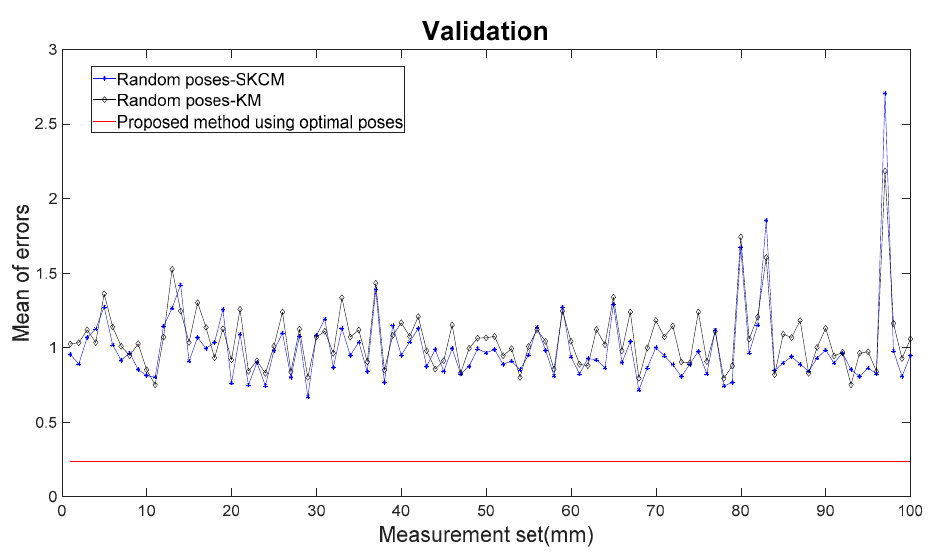
Figure 8. Result of the validation process.